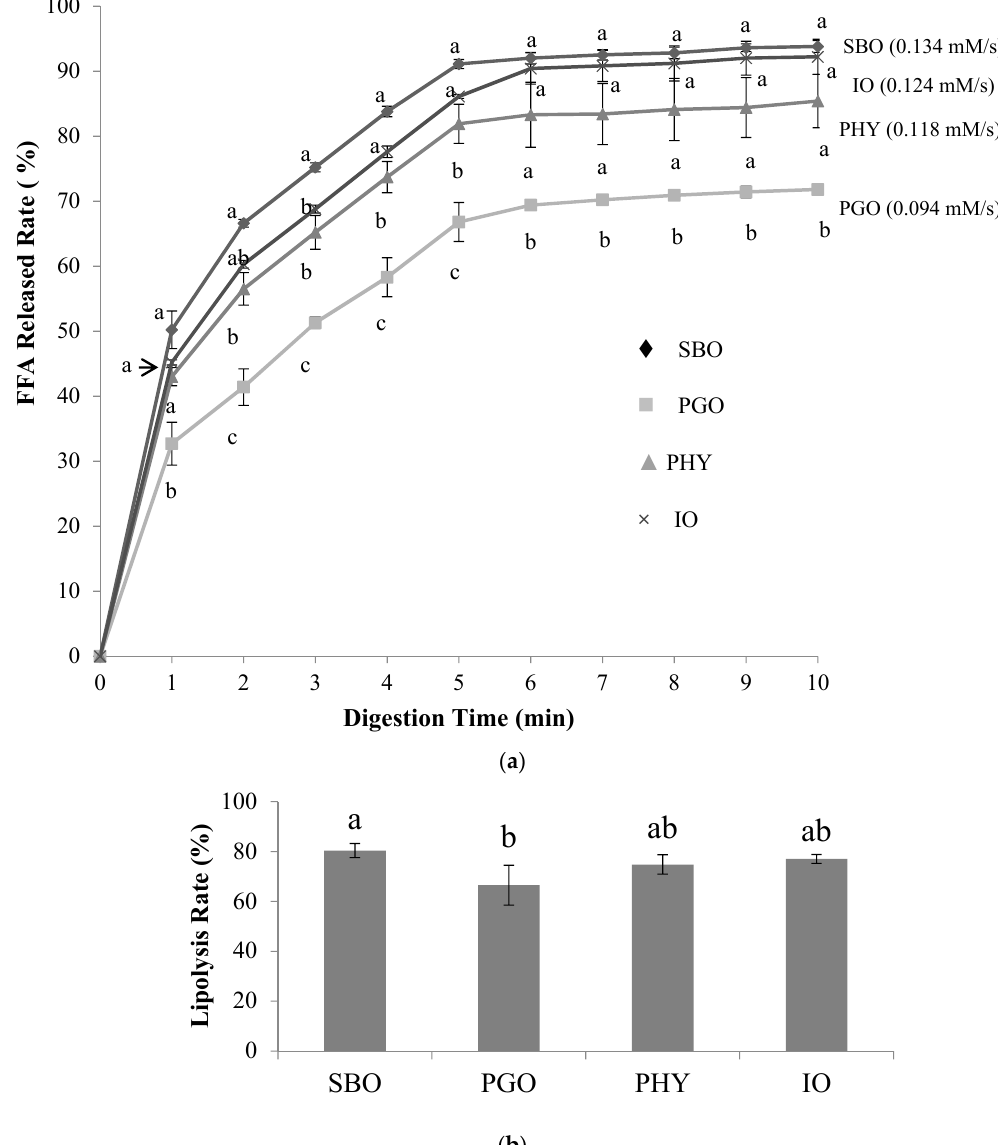
Figure 2. The free fatty acid (FFA) release rates (%) and initial rates (mM/s) in a pH-stat digestion model ( a ); and lipolysis rates (%) after 30 min of digestion in the simulated model of small intestinal digestion ( b ). Statistical differences are indicated by letters where significant differences were detected ( p < 0.05). Abbreviation: SBO, soybean oil; PGO, pomegranate seed oil; PHY, physical blend; IO, interesterified oil.